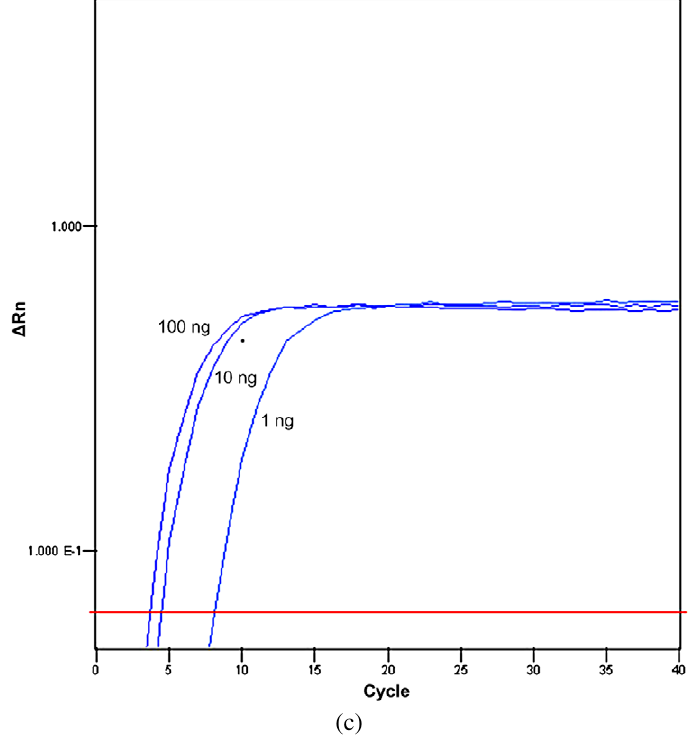
Fig. 3. (Continued.) (Colors are visible in the online version of the article;